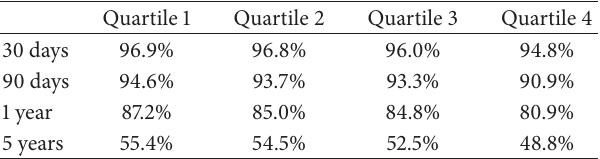
Table 2: Comparison of survival rate after LT at 30 days, 90 days, 1 year, and 5